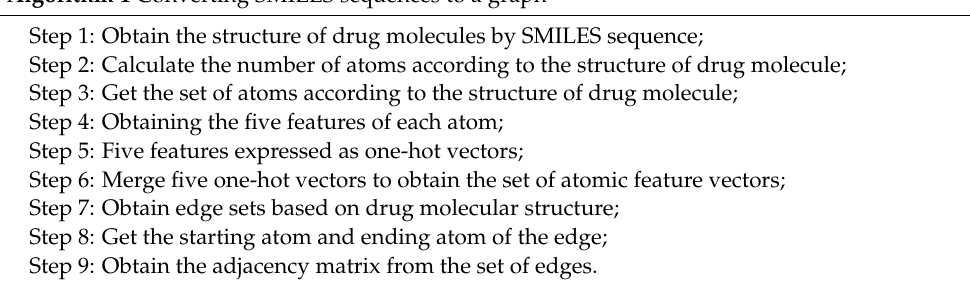
Algorithm 1 Converting SMILES sequences to a graph